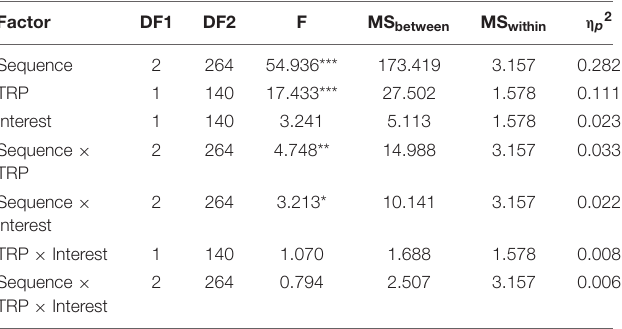
TABLE 2 | ANOVA results for evaluation score.